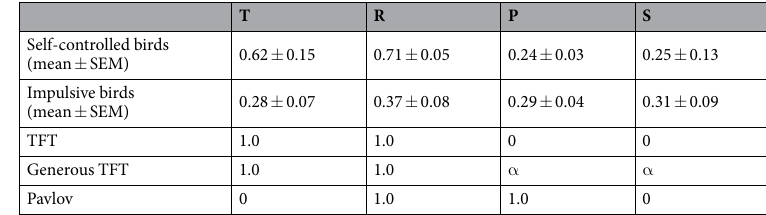
Table 1. Observed and expected probability that a subject chooses to cooperate in a given trial after having received payoffs T, R, P and S, respectively. While a TFT player systematically defects after its opponent’s defection, an individual playing a Generous TFT strategy is expected to continue cooperating with a probability α after both payoffs P and